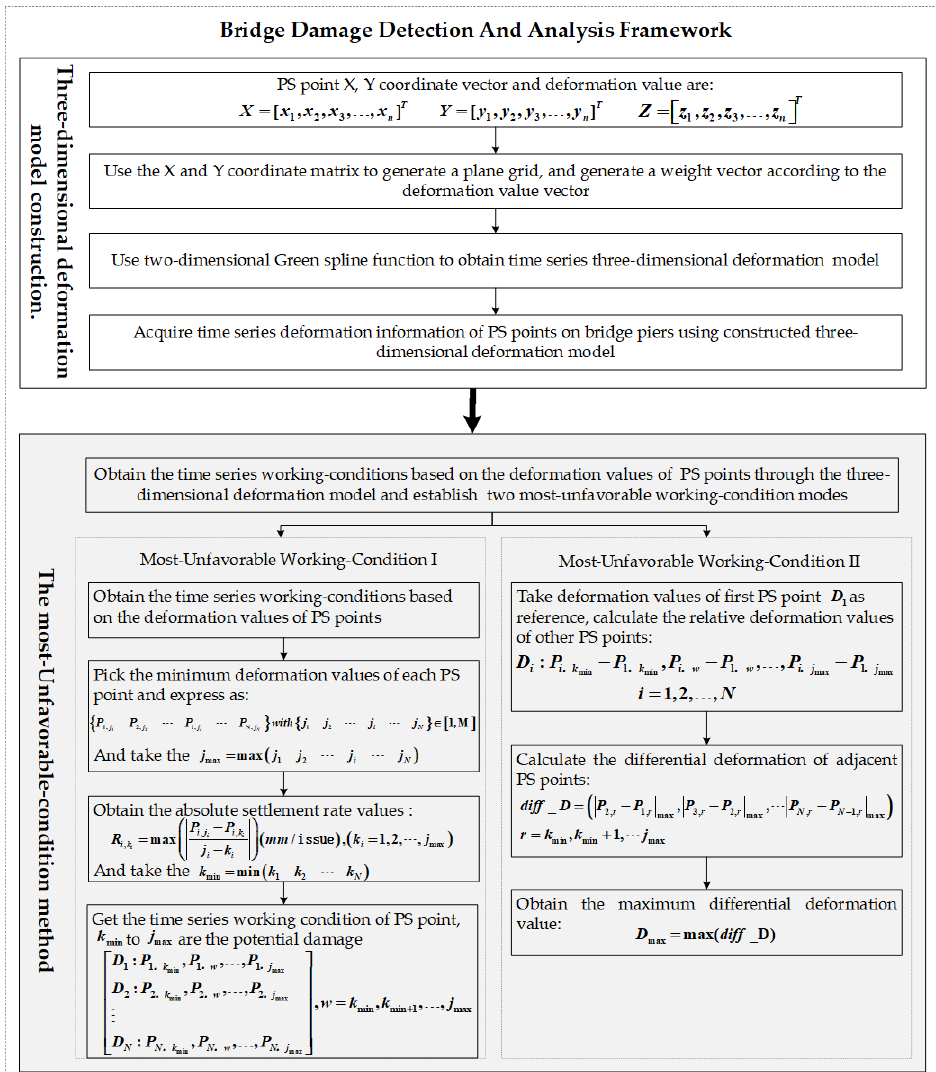
Figure 3. Technical and analytical frameworks of bridge-damage detection.